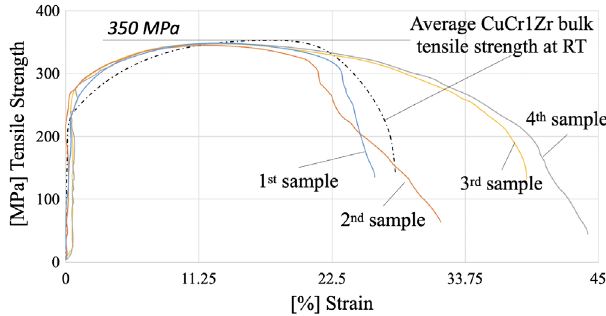
FIG. 15. Room temperature tensile stress-strain curves for CuCr1Zr-CuCr1Zr specimens and bulk hardened CuCr1Zr.